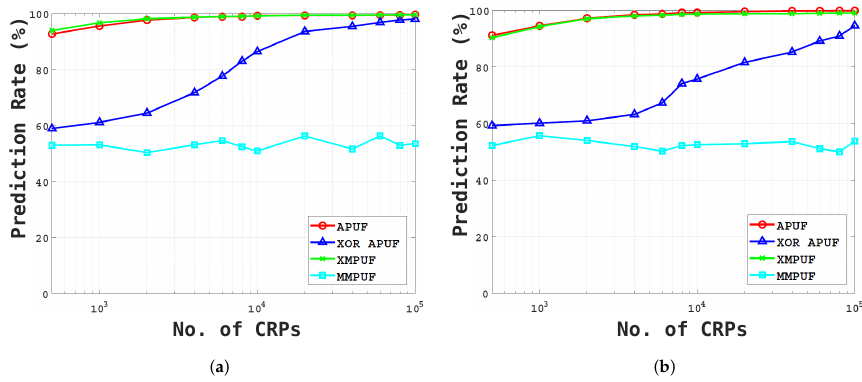
Figure 10. The prediction rates of SVM attack on: ( a ) 64 bit and, ( b ) 128-bit MMPUF designs. The final prediction rates and training time for the APUF, XOR APUF, XMPUF and MMPUF